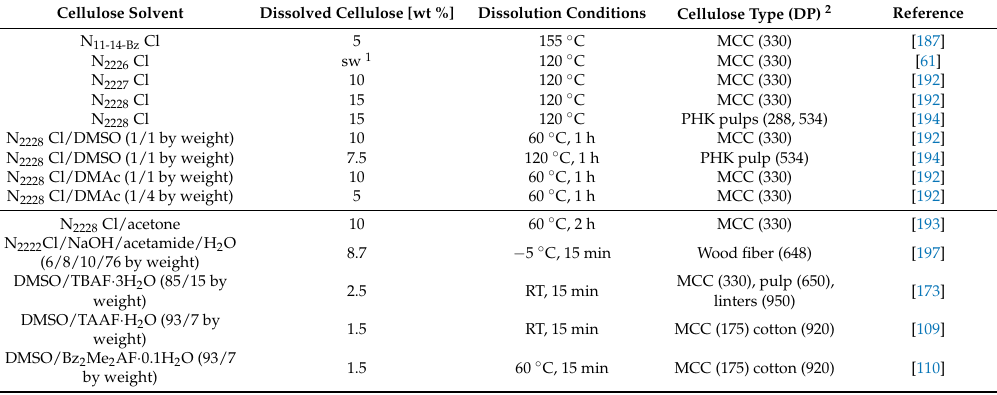
Table 4. Summary of the solubility of cellulose in quaternary ammonium